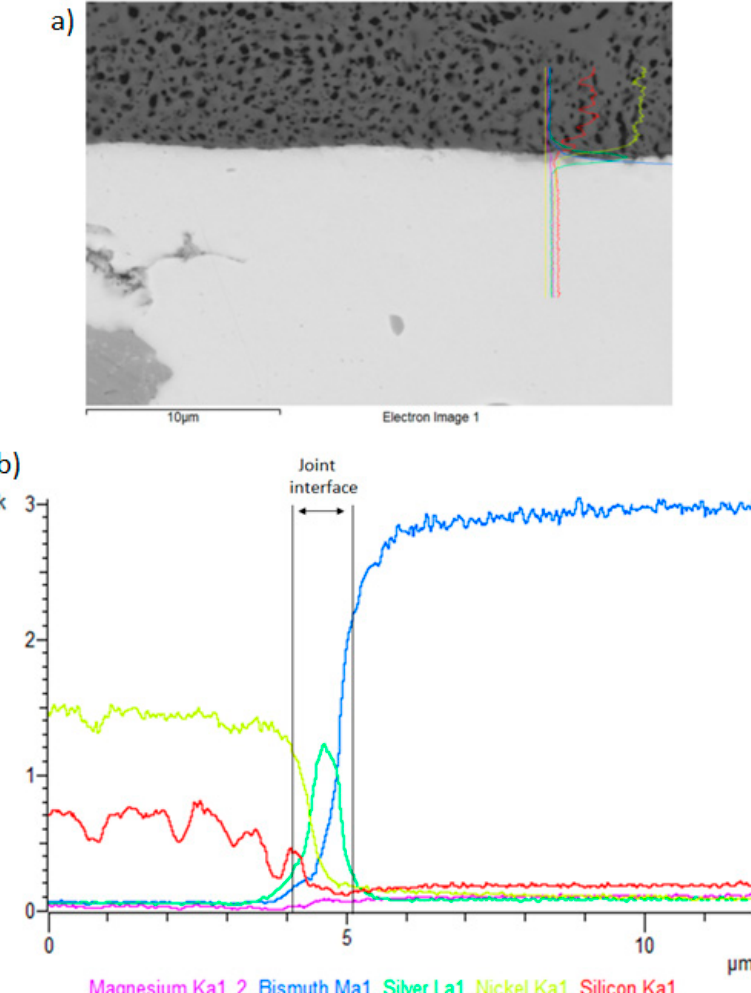
Figure 19. Line EDX analysis for the Bi11Ag1Mg/Ni–Sic joint: ( a ) a marked transition zone; ( b ) concentration profiles of Mg, Bi, Ag, Ni, and Si elements.